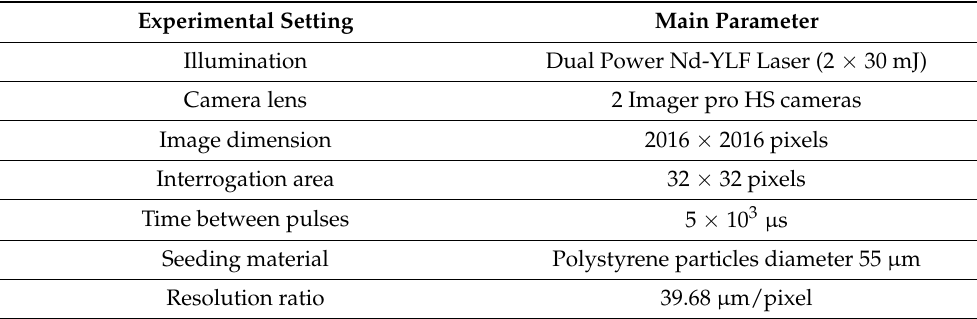
Table 1. Experimental settings for PIV